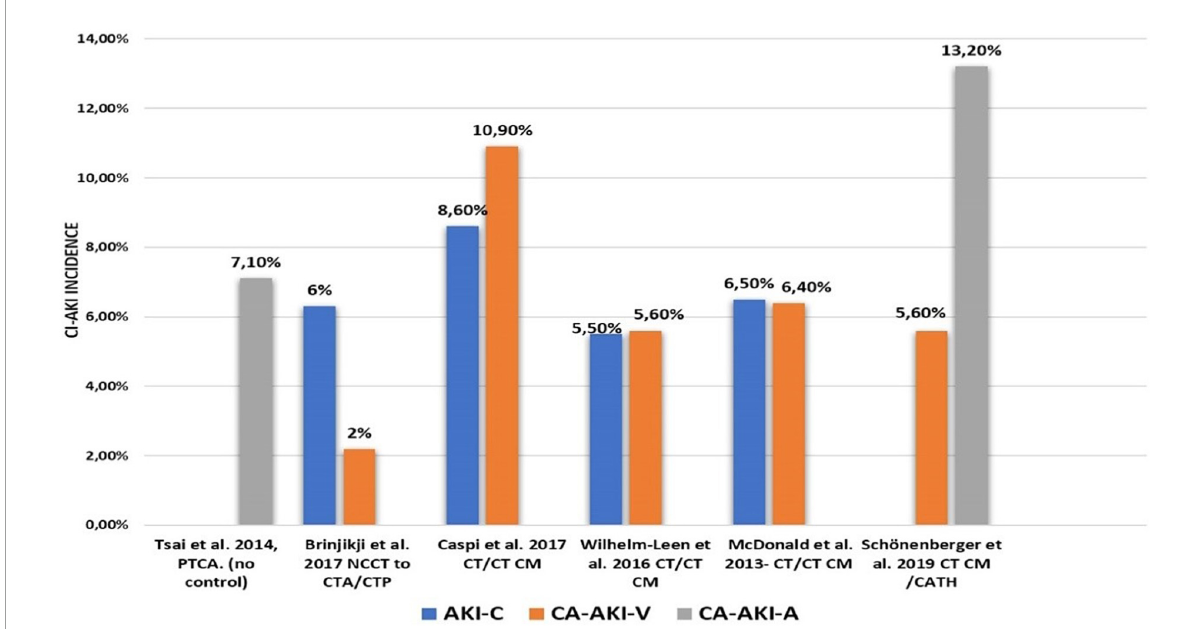
FIGURE1 Incidence of Cl-AKI reported in selected recent studies. Tsai et al. (21); McDonald et al. (23); Wilhelm-Leen et al. (24); Schönenberger et al. (27); Ward et al. (29); Kiss and Hamar (30). CI-AKI, contrast induced acute kidney injury; PTCA, percutaneous transluminal coronary angioplasty; CTA, computed tomography angiography; CTP, computed tomography perfusion; NCCT, noncontrast computed tomography; CTCM, compute tomography with contrast; CATH, coronary vessels catheterisation; AKI-C, acute kidney injury control; CA-AKI-V, venous contrast application as the causative factor of CA-AKI, CA-AKI-A, arteria contrast application as the causative factor of